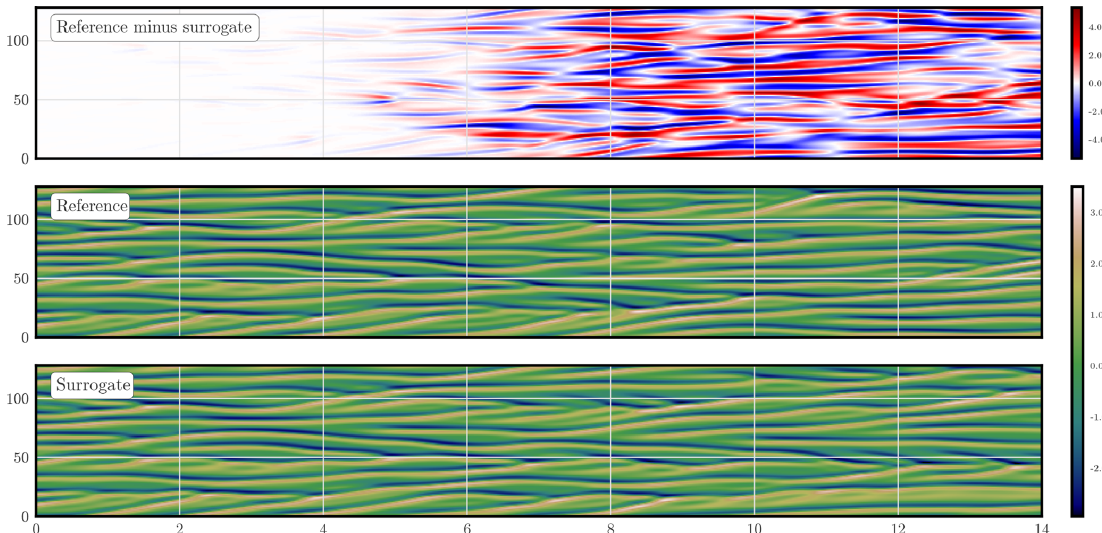
Figure 5. Density plot of the KS reference and surrogate model trajectories, as well as their difference trajectory, as a function of the forecast lead time (in Lyapunov time unit). The observations are noiseless and dense; the model is not identifiable.